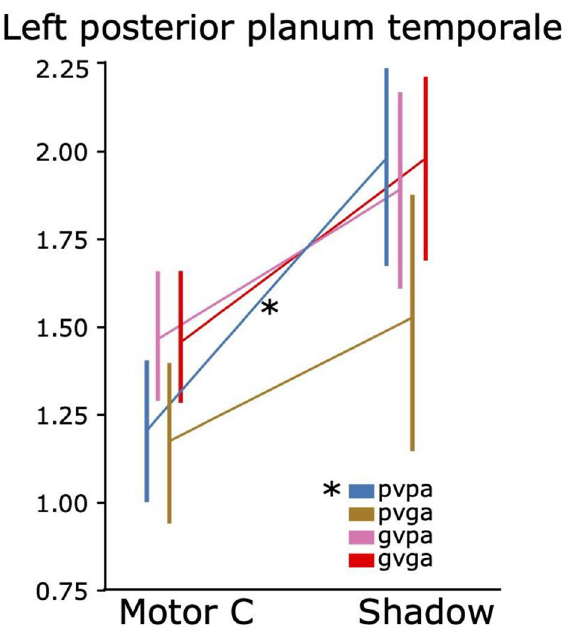
Figure 8. In the left posterior planum temporale (pPT), there was a significant difference in the mean % signal change between the shadowing (Shadow) condition with poor auditory and poor visual quality and the corresponding motor control (Motor C) condition. *p < 0.05, FWER corrected. pv poor visual quality, pa poor auditory quality, gv good visual quality, ga good auditory